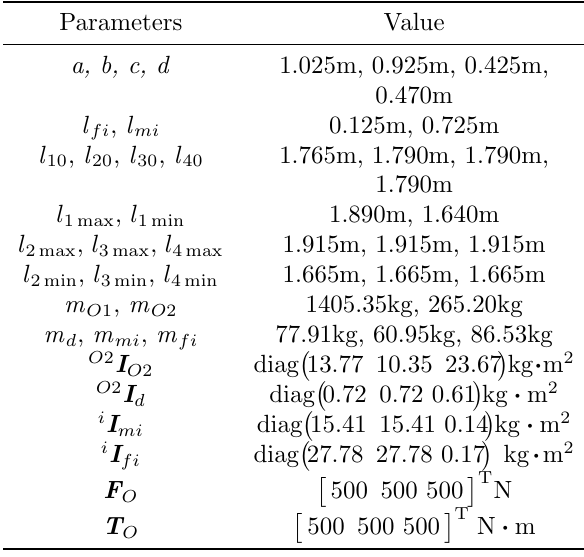
Table 4: The parameters of the machine tool ( i =1, 2, 3,